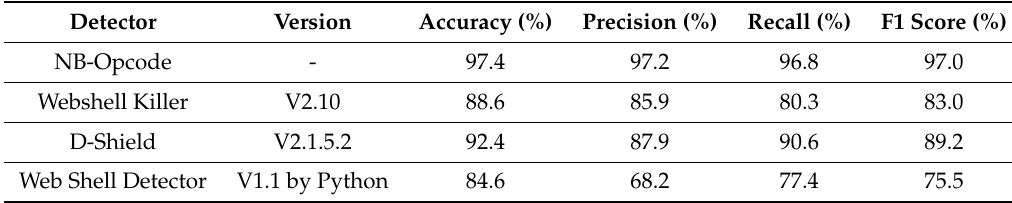
Table 5. Comparison with webshell detector